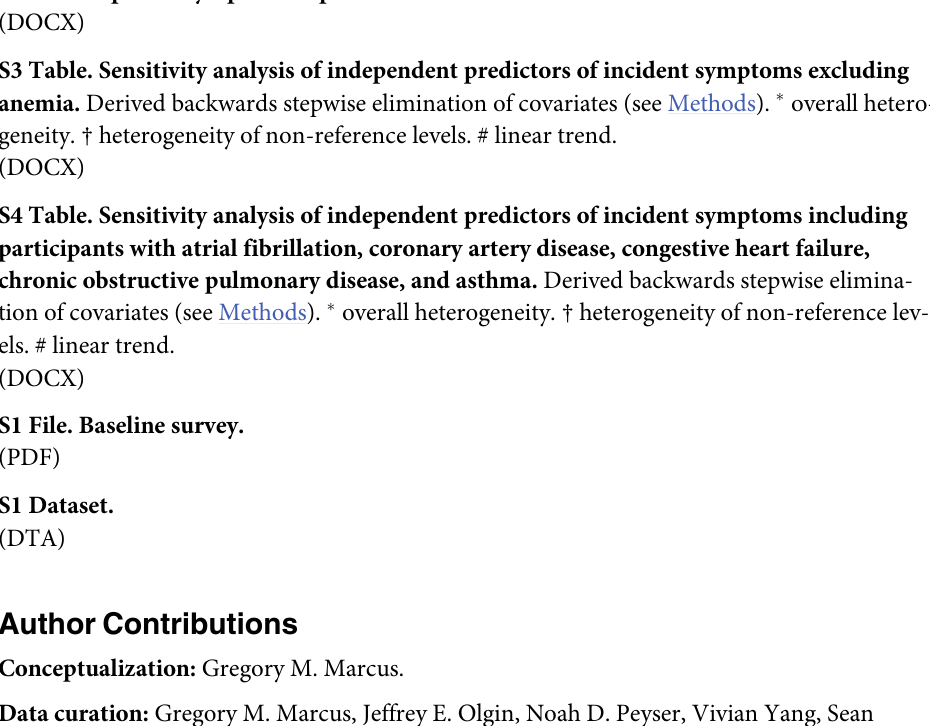
S1 Table. Proportion of participants completing at least one daily survey per week and the proportion completing weekly surveys. S2 Table. Specific symptoms reported in addition to fevers and chills. S3 Table. Sensitivity analysis of independent predictors of incident symptoms excluding anemia. Derived backwards stepwise elimination of covariates (see Methods). � overall hetero- geneity. † heterogeneity of non-reference levels. # linear trend. S4 Table. Sensitivity analysis of independent predictors of incident symptoms including participants with atrial fibrillation, coronary artery disease, congestive heart failure, chronic obstructive pulmonary disease, and asthma. Derived backwards stepwise elimina- tion of covariates (see Methods). � overall heterogeneity. † heterogeneity of non-reference lev- els. # linear